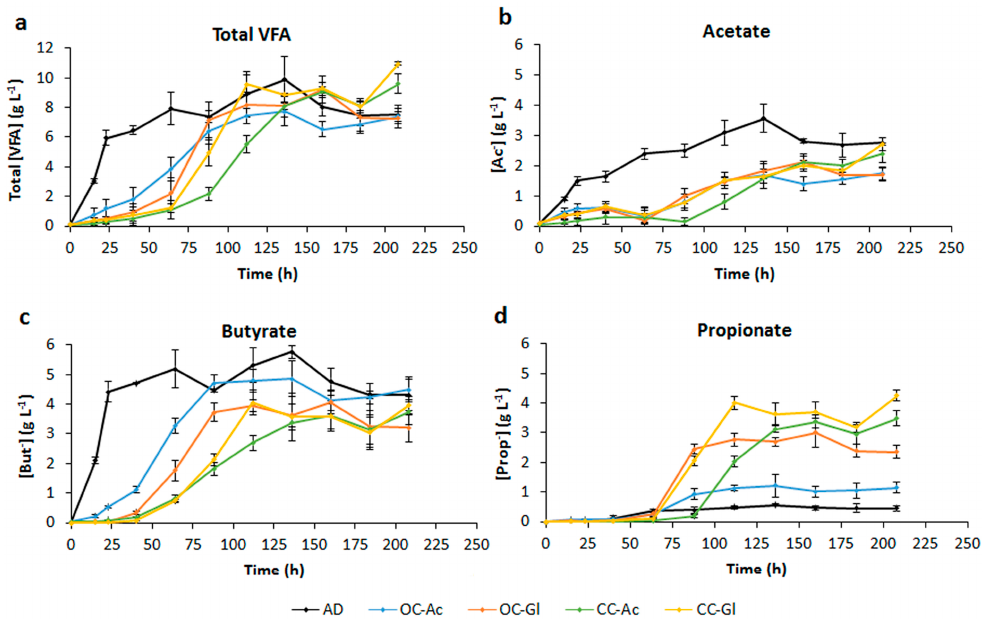
Figure 3. VFA evolution of the combined AD-BES reactors and anaerobic digester working under acidogenic conditions. Total concentrations of ( a ) VFAs; ( b ) acetate; ( c ) butyrate; and ( d ) propionate for all conditions tested. AD: Anaerobic digester; OC-Ac and OC-Gl: open-circuit reactors adapted with acetate and glucose, respectively; CC-Ac and CC-Gl: closed-circuit reactors adapted with acetate and glucose, respectively.